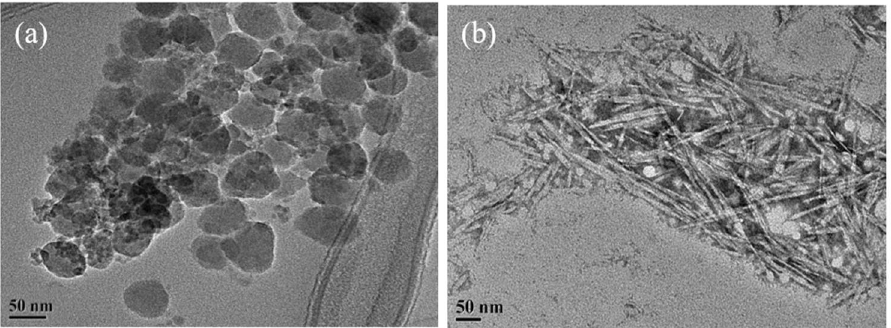
Figure 2. Transmission electron microscopy micrographs of a dilute suspension of ( a ) nano-ZnO, and ( b ) CNCs-ZnO particles.